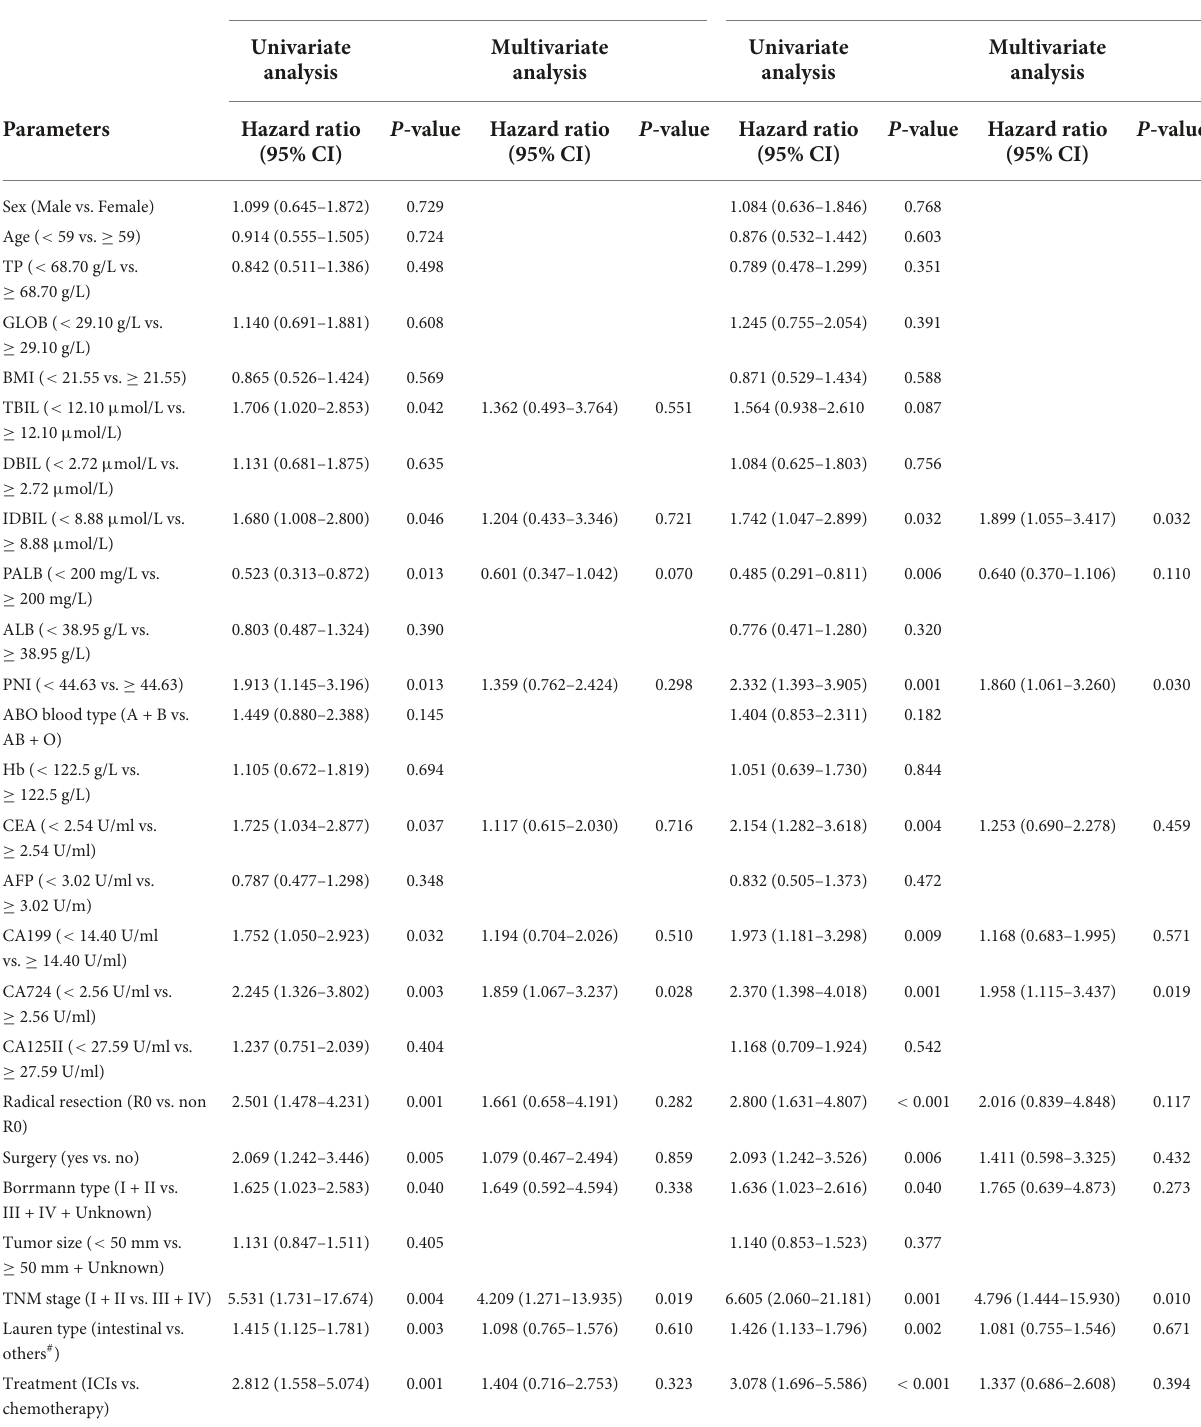
TABLE 3 Univariate and multivariate analyses for progression-free survival (PFS) and overall survival